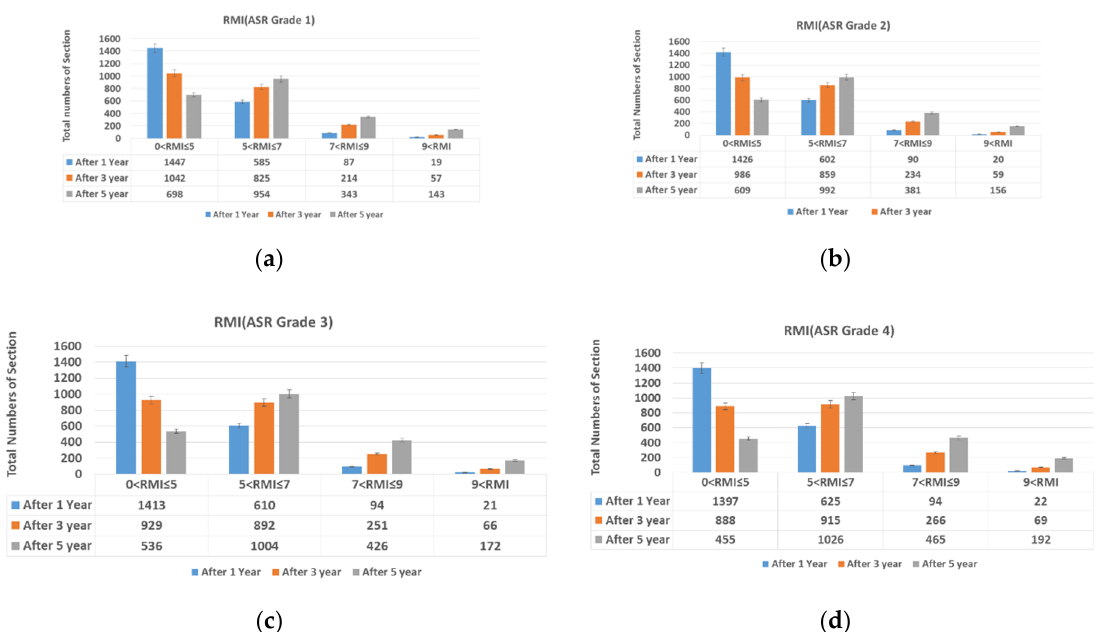
Figure 1. Total number of sections by ASR grade and RMI ( a ) ASR grade 1; ( b ) ASR grade 2; ( c ) ASR grade 3; and ( d ) ASR grade 4.